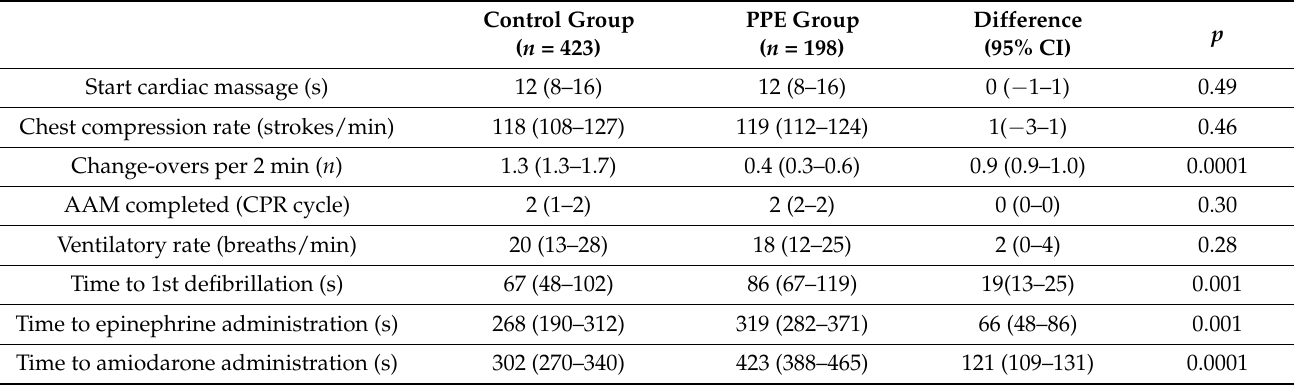
Table 1. Performance metrics of CPR.